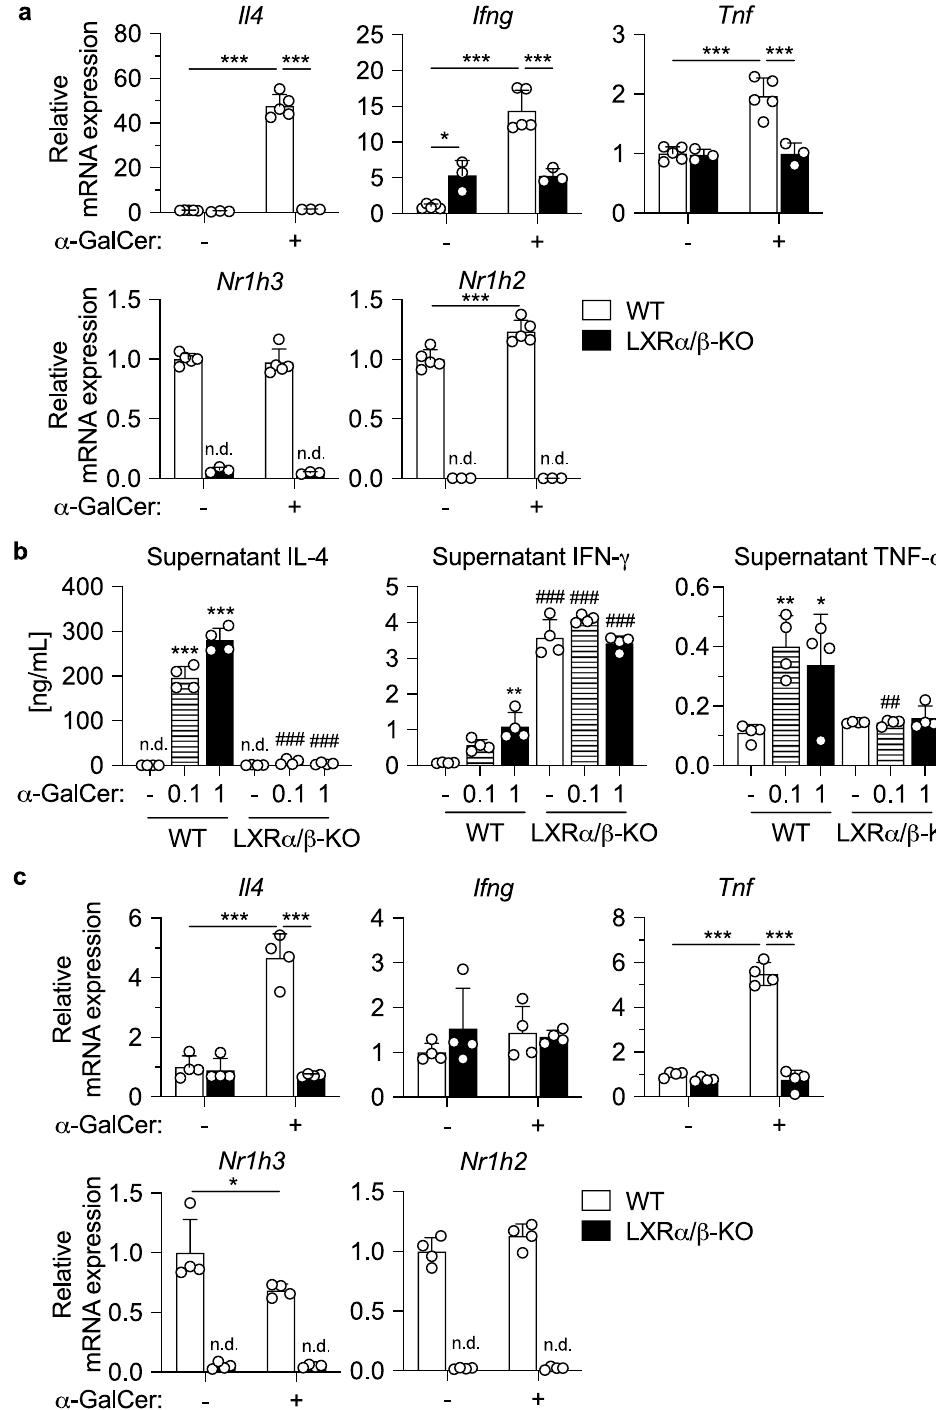
Figure 2. Impaired cytokine production in NKT cells from the liver and spleen of LXRα/β-KO mice. ( a ) mRNA expression of Il4 , Ifng , Tnf , Nr1h3 and Nr1h2 in hepatic MNCs activated by the iNKT cell activator α-GalCer. Hepatic MNCs were isolated form WT and LXRα/β-KO mice and cultured with vehicle control (dimethyl sulfoxide) or α-GalCer (10 ng/ml) for 6 h (n = 3–5). ** P < 0.01, *** P < 0.001 (one-way ANOVA followed by Tukey’s multiple comparisons). ( b ) Protein levels of IL-4, IFN-γ and TNF-α in culture media of hepatic MNCs simulated with α-GalCer. Hepatic MNCs were cultured with vehicle control (dimethyl sulfoxide), 0.1 or 1 µg/ml α-GalCer for 16 h, and concentrations of IL-4, IFN-γ and TNF-α in culture media were measured with enzyme-linked immunosorbent assay (n = 4). n.d., not detected. * P < 0.05, ** P < 0.01, *** P < 0.001 compared to vehicle control treatment (one-way ANOVA followed by Tukey’s multiple comparisons). ## P < 0.01, ### P < 0.001 compared to WT cells with the same treatment (Student’s t test). ( c ) mRNA expression of Il4 , Ifng , Tnf , Nr1h3 and Nr1h2 in splenocytes stimulated with α-GalCer. Splenocytes were isolated from WT and LXRα/β-KO mice and cultured with vehicle control (dimethyl sulfoxide) or α-GalCer (1 ng/ml) for 6 h (n = 4). n.d., not detected. * P < 0.05, *** P < 0.001 (one-way ANOVA followed by Tukey’s multiple